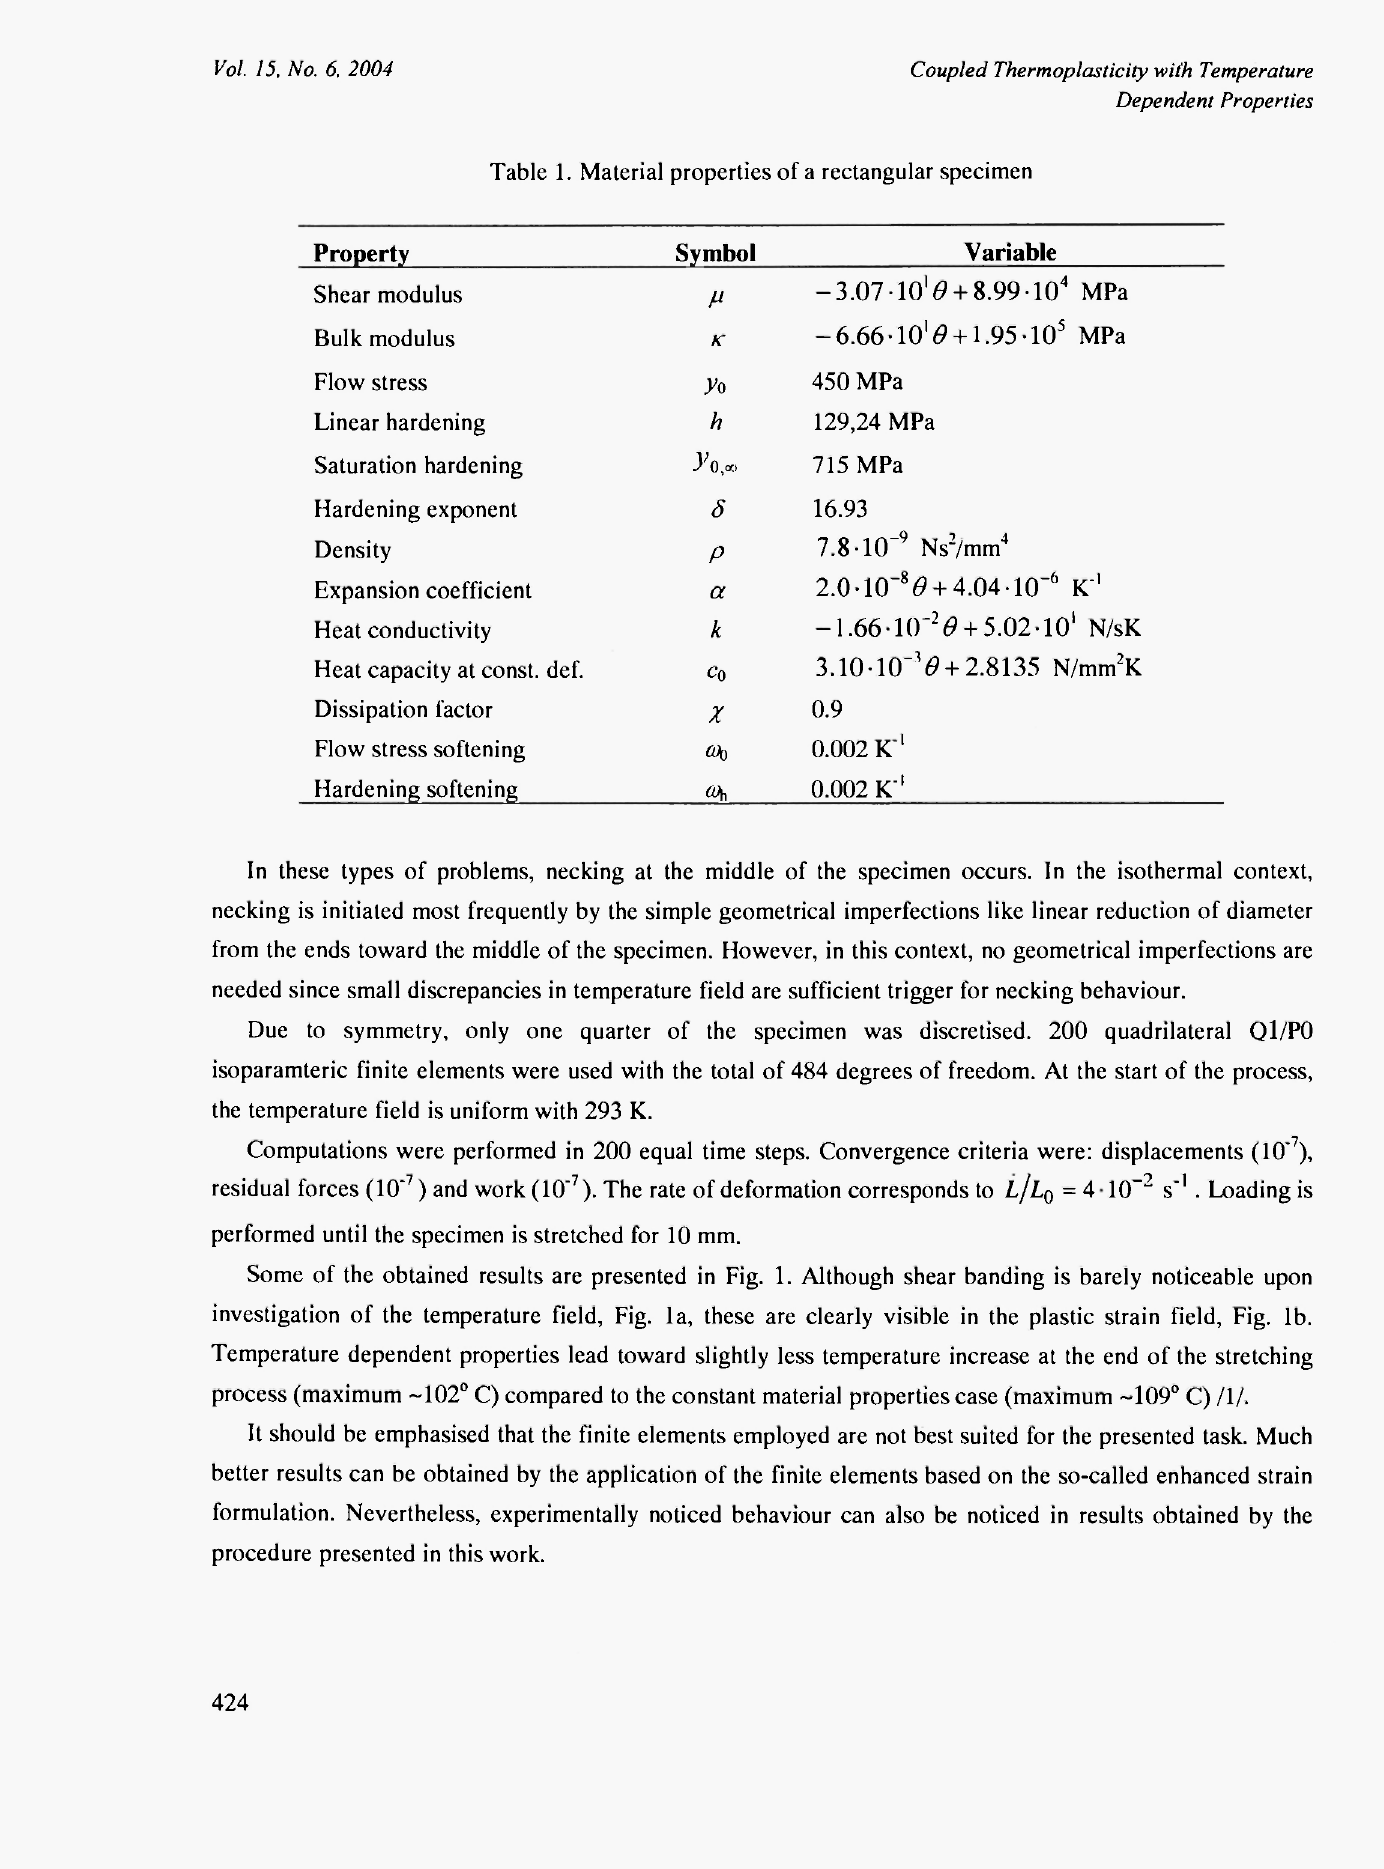
Table 1. Material properties of a rectangular